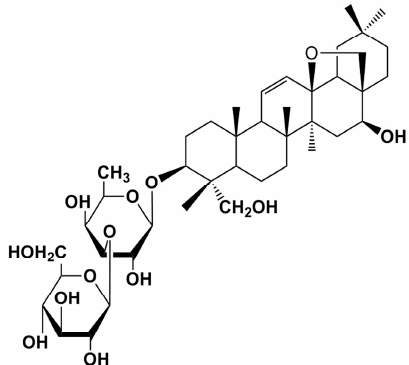
Figure 1. Structural formula of SS-A.